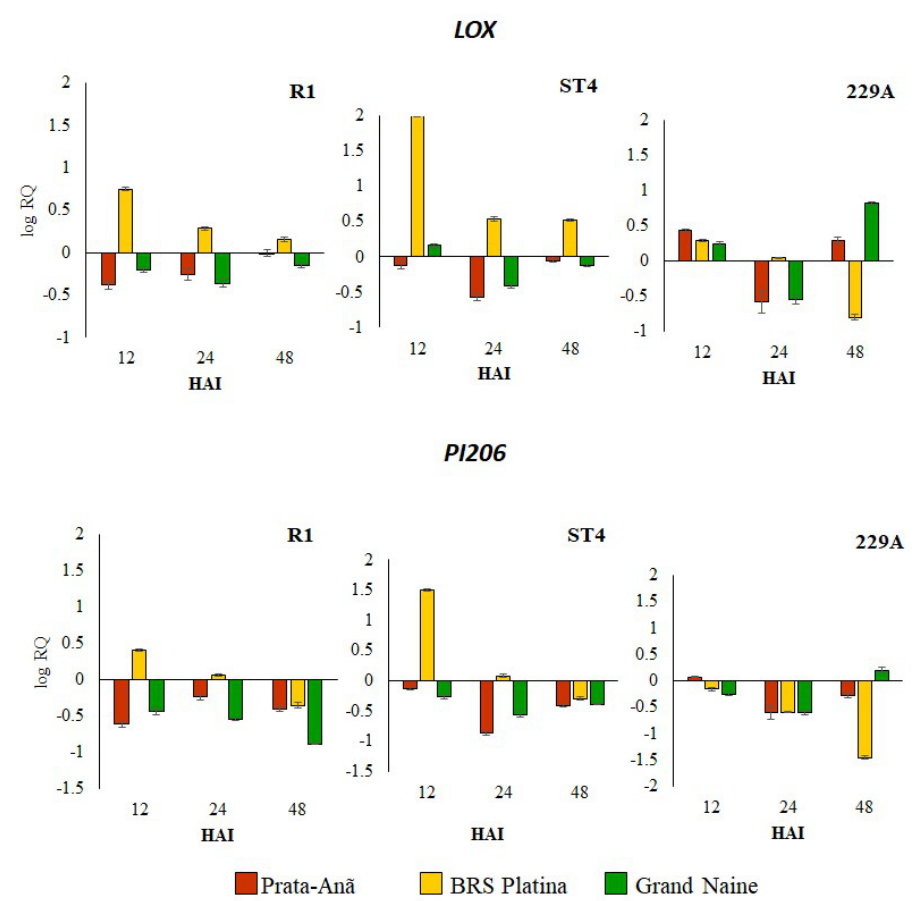
Figure 2. Relative expression levels of two defense-related genes in banana genotypes at 12, 24 and 48 h after inoculation (HAI) with Fusarium oxysporum f. sp. cubense races 1 (Foc R1), subtropical 4 (Foc ST4) and isolate 229A. Levels of relative expression of the genes related to the defense lipoxygenase (LOX) and putative disease resistance response protein 206 (PI206) were analyzed by RT-qPCR. The data represent the means ± standard deviations of three biological replicates and three technical replicates. QR values correspond to genes with differential expression at 12, 24 and 48 h after inoculation (HAI) compared to 0 HAI (non-inoculated plants).